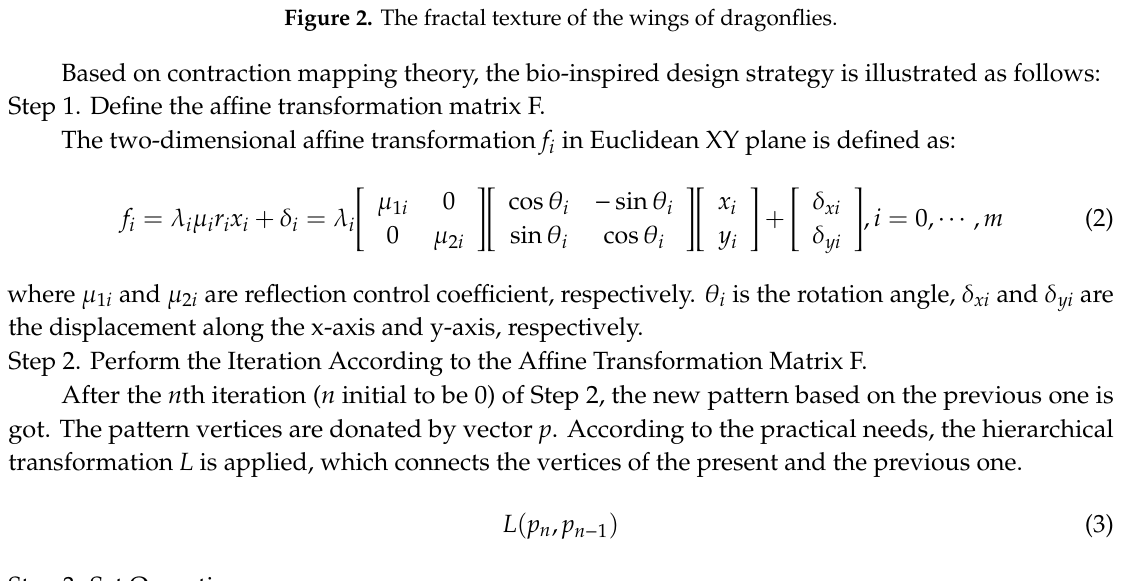
thin-walled triangle column. The initial triangle column is expressed as the 0th-order structure. D is the side length of the smallest triangle. Q is the total side number of all triangles. L is the total length of the sides. t is the thickness. More configuration details are shown in Table Table 1. Configuration details of fractal curves.